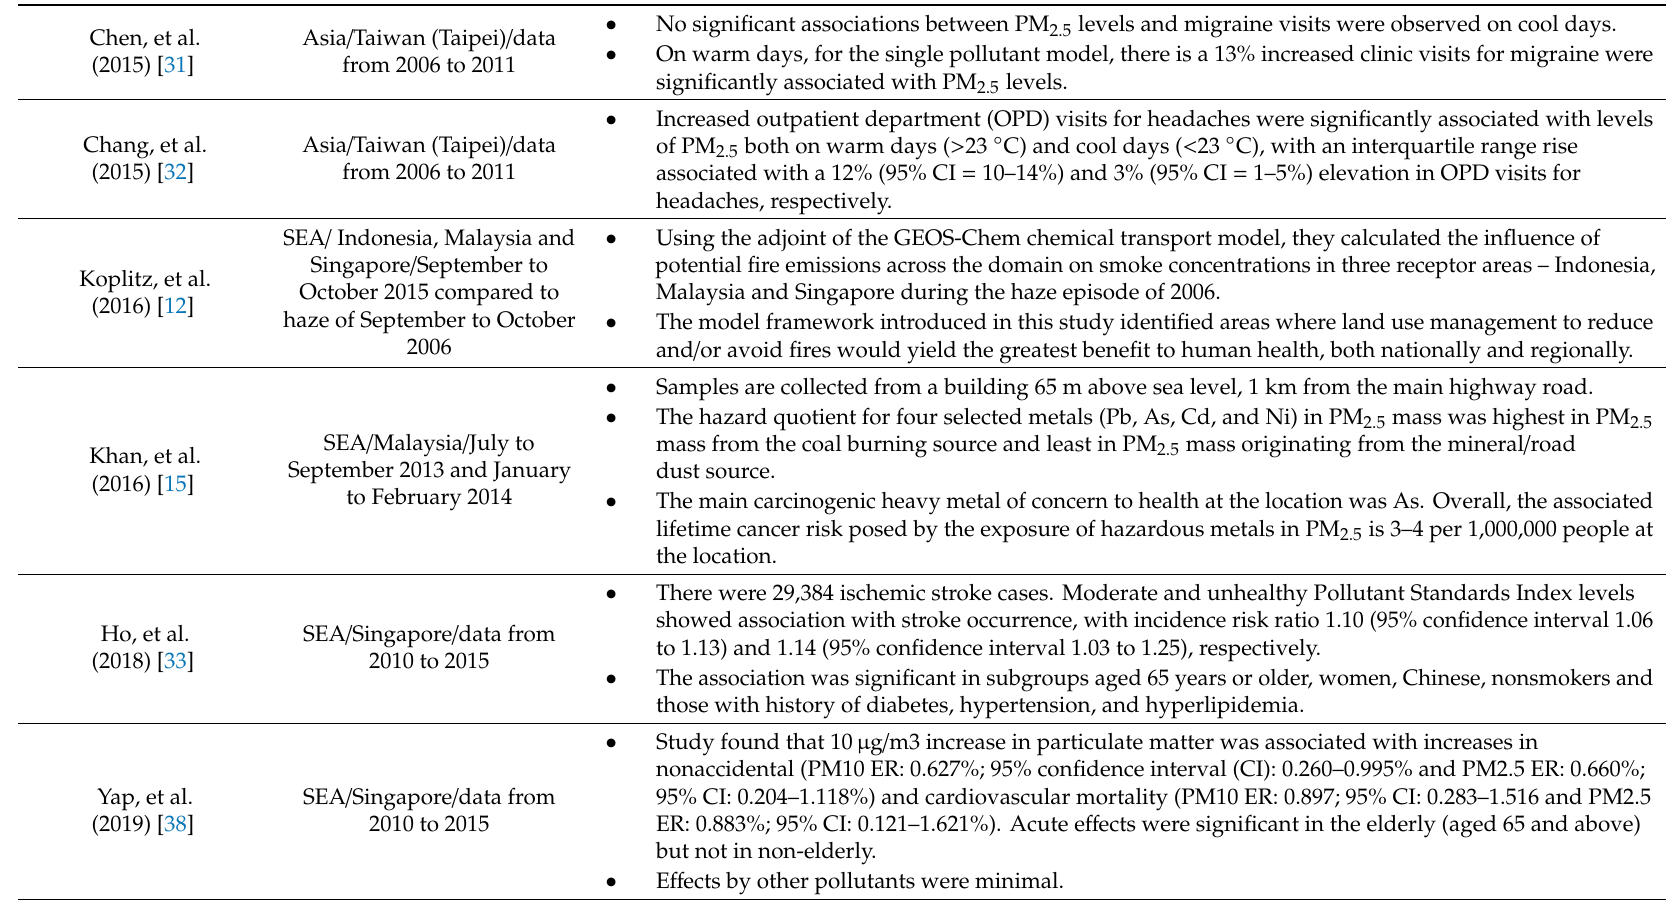
• No significant associations between PM 2.5 levels and migraine visits were observed on cool days. • On warm days, for the single pollutant model, there is a 13% increased clinic visits for migraine were from 2006 to 2011 significantly associated with PM 2.5 levels.